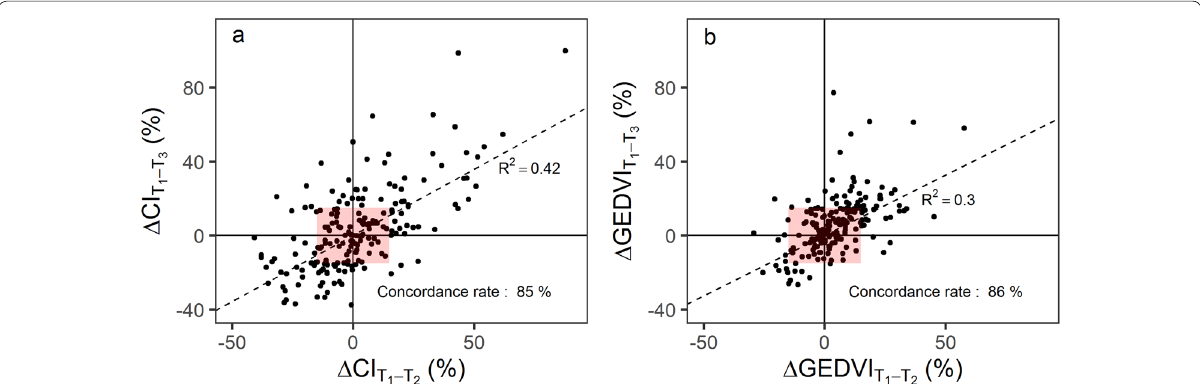
Fig. 2 Early versus late changes in CI ( a ) and GEDVI ( b ) during prone position. Symbols are individual values for each prone position session. Broken lines are regression lines performed on the whole dataset with corresponding R 2 . Concordance rate is the percentage of data points falling into one of the two quadrants of agreement (i.e., upper right and lower left quadrants in which hemodynamic variations between T 1 and T 2 and between T 1 and T 3 have the same directional changes). Red rectangles are exclusion zones for computation of concordance rate, excluding data points with changes in both variables below 15%. ΔCI T1–T2 : change in CI between T 1 and T 2 ; ΔCI T1–T3 : change in CI between T 1 and T 3 ; ΔGEDVI T1–T2 GEDVI between T